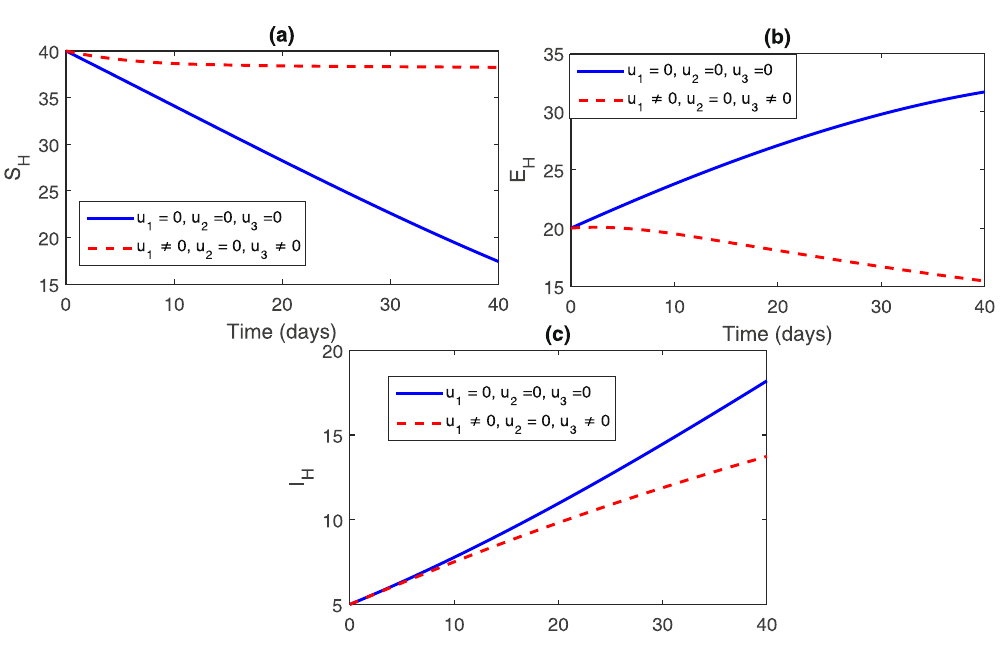
Figure 4. Comparison of both the systems: without and with